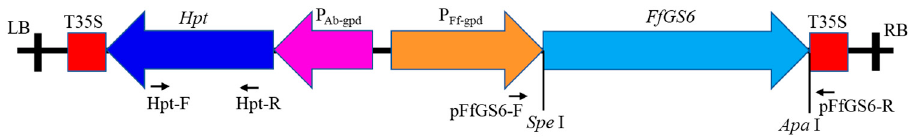
Figure 1. Schematic diagram of pBHg- FfGS6 -OE recombinant plasmid T-DNA region. Hpt-F/Hpt-R, resistance gene amplification primer sites; pFfGS6-F/pFfGS6-R, target gene amplification primer sites; Spe I and Apa I, restriction sites.